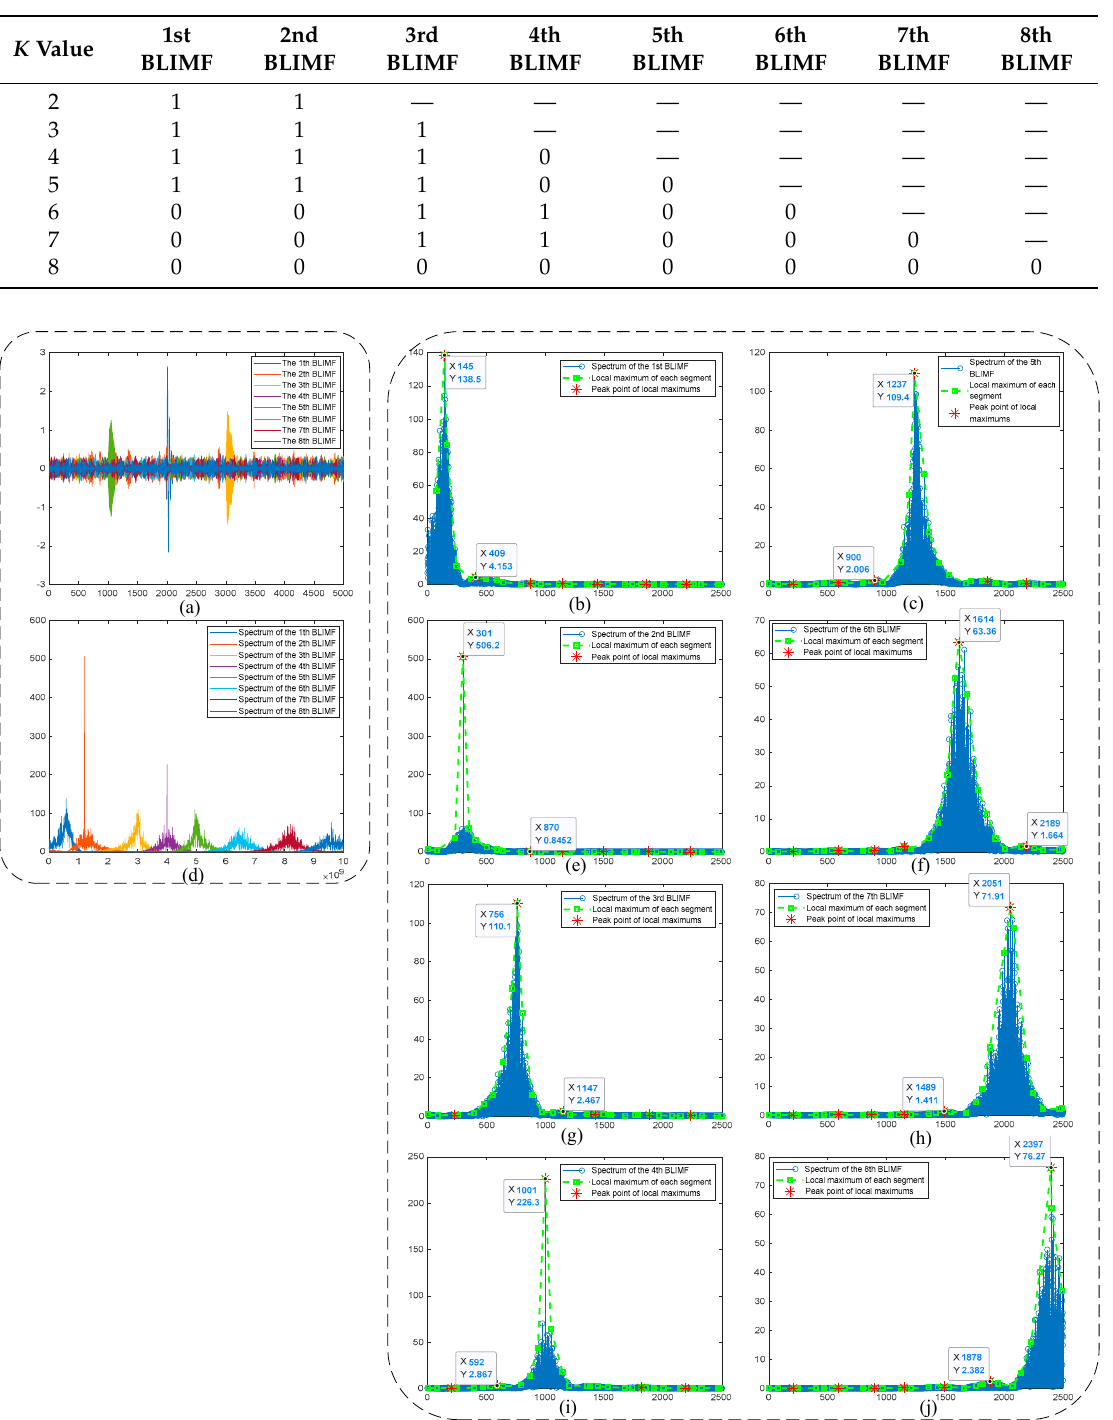
Table 3. Mode-mixing judgement results of BLIMFs for each K value. ‘1 ′ means mode-mixing happened, while ‘0 ′ means no mode-mixing happened.